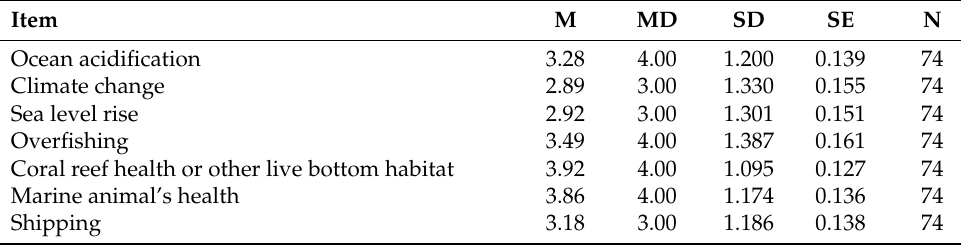
Table 4. Respondents’ Concern Levels Regarding Ocean Resources Inside